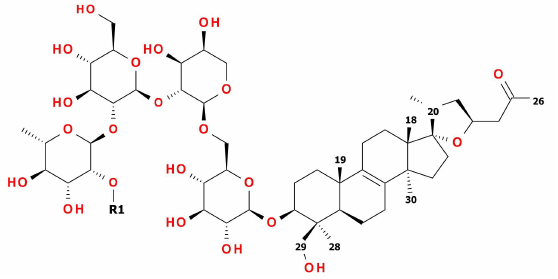
Figure 1. Structures of 12 (R1 = 1- β -D-Glc p ) and 13 (R1 =